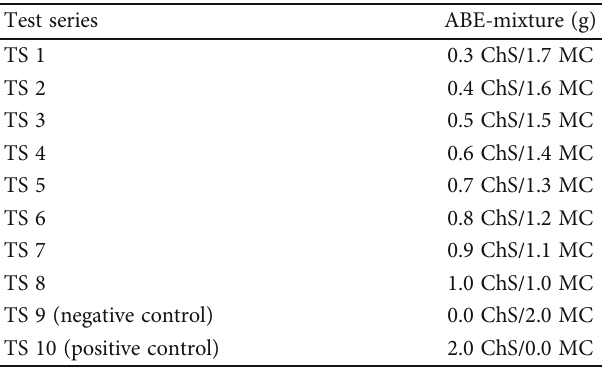
Table 1: Test series with mixing ratios of ChS/MC in 100ml aqueous solution containing 2% acetic